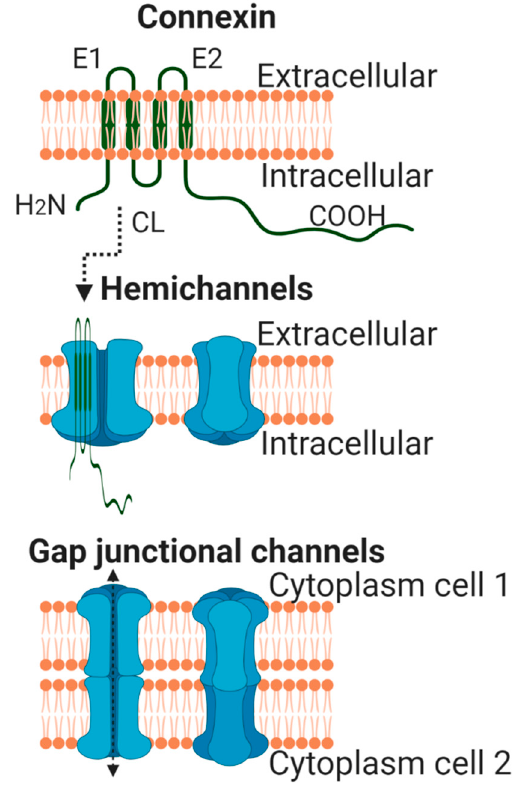
Figure 1. Schematic view of a single connexin molecule located at the plasma membrane (upper panel). Lower panels depict hemichannels and intercellular or gap junctional channels. Created with Biorender.com (accessed on 15 April 2021). Modified from [11,12].